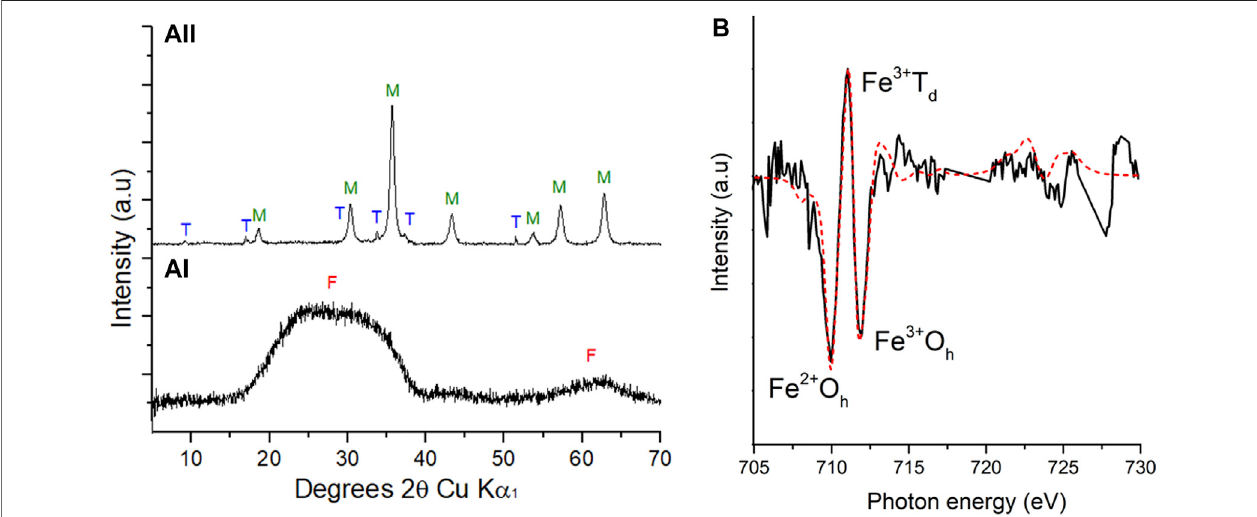
Table 1 for XMCD at 9